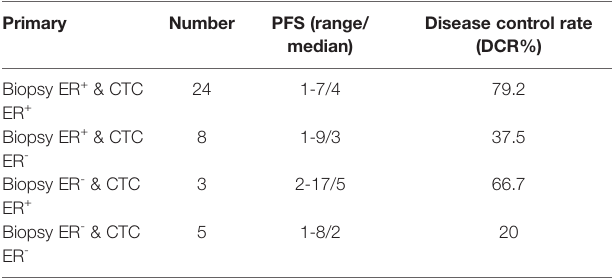
TABLE 2 | Expression pro fi les for ER of IHC results and CTCs, and available PFS and DCR information in the subgroup of patients with available primary tumor IHC results.